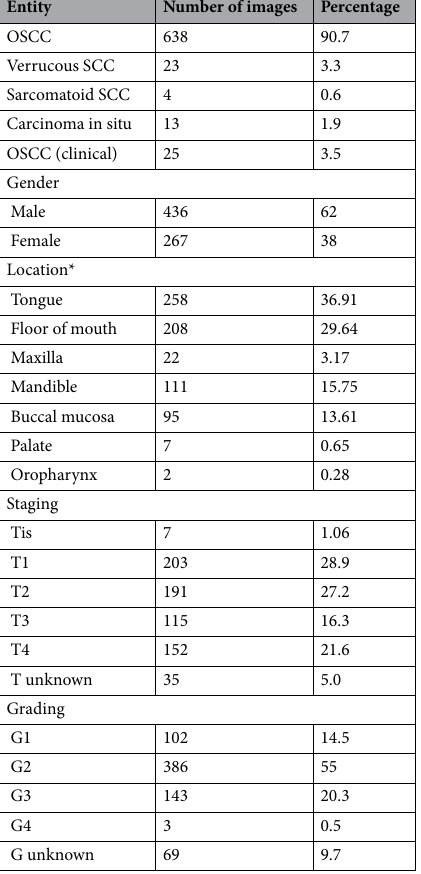
Table 1. Baseline characteristics of the malignant pathologies. Multiple locations of extended lesions possible